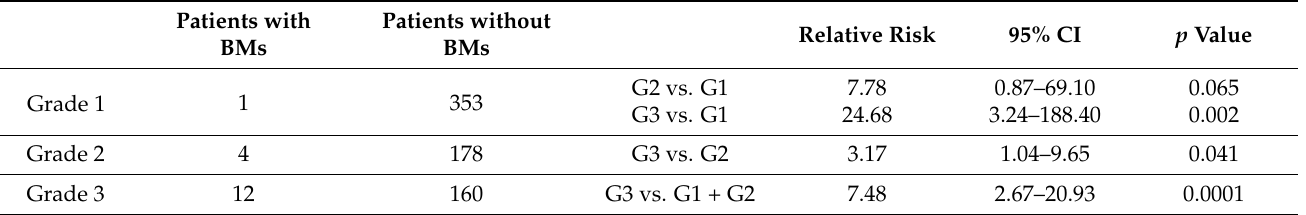
Table 3. The relative risk ratios of developing brain metastases when comparing between histological grades of extra-pulmonary neuroendocrine neoplasms.